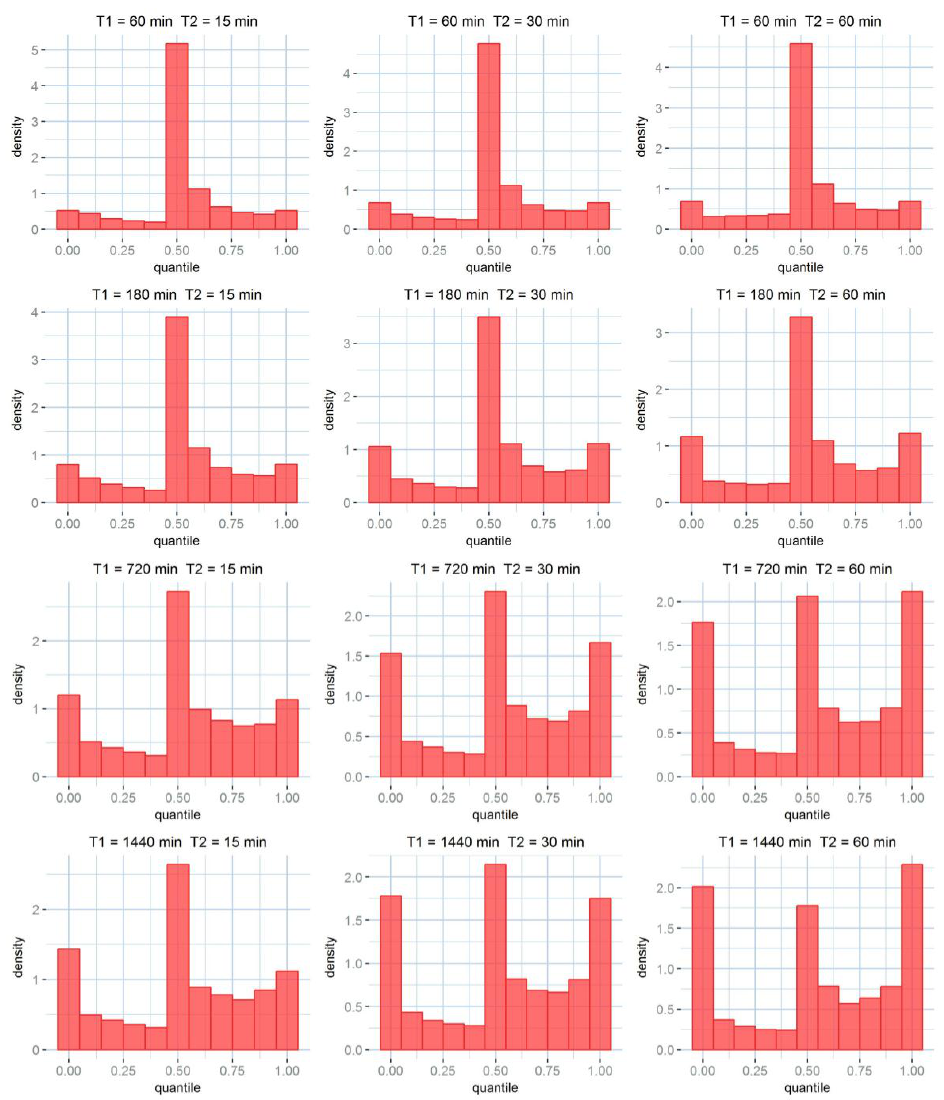
Figure 6. Rank histograms for the tested accumulation ( T 1 ) and downscaling ( T 2 ) combinations in the UK case study.